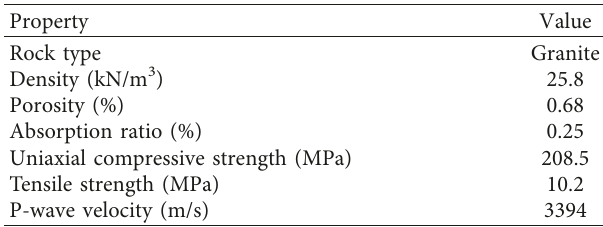
Table 1: Properties of the rock specimen.